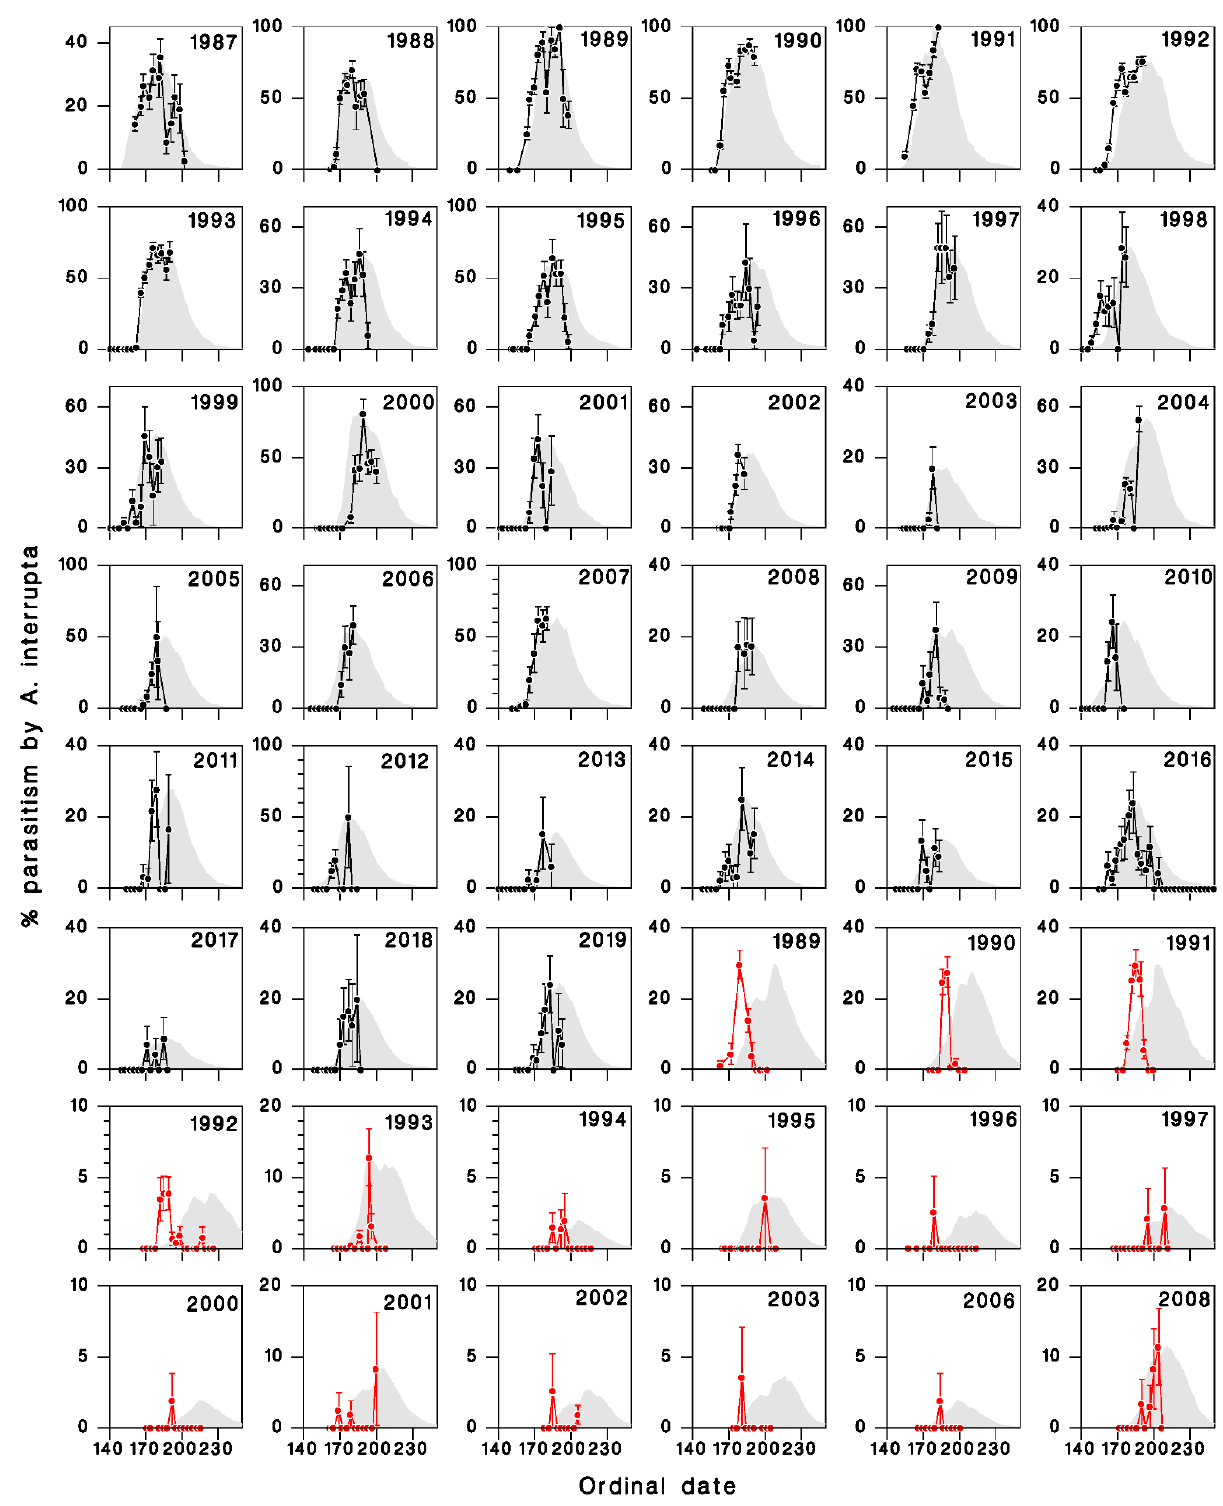
Figure 4. Comparison of attack rates on sentinel SBW larvae exposed in Armagh ( • ) and at Epaule ( • ), and predicted abundance of first-generation A. interrupta adults ( shaded curves ). Vertical bars are standard deviations ( (cid:3493)𝑝𝑞/𝑛 ). Note that the predicted adult abundance is adjusted so maximum observed and predicted values correspond.